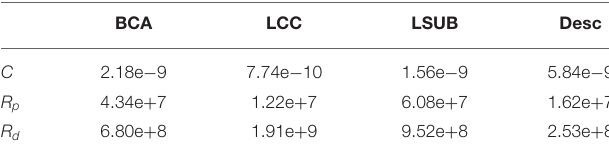
levels are reported. Figure 4 depicts